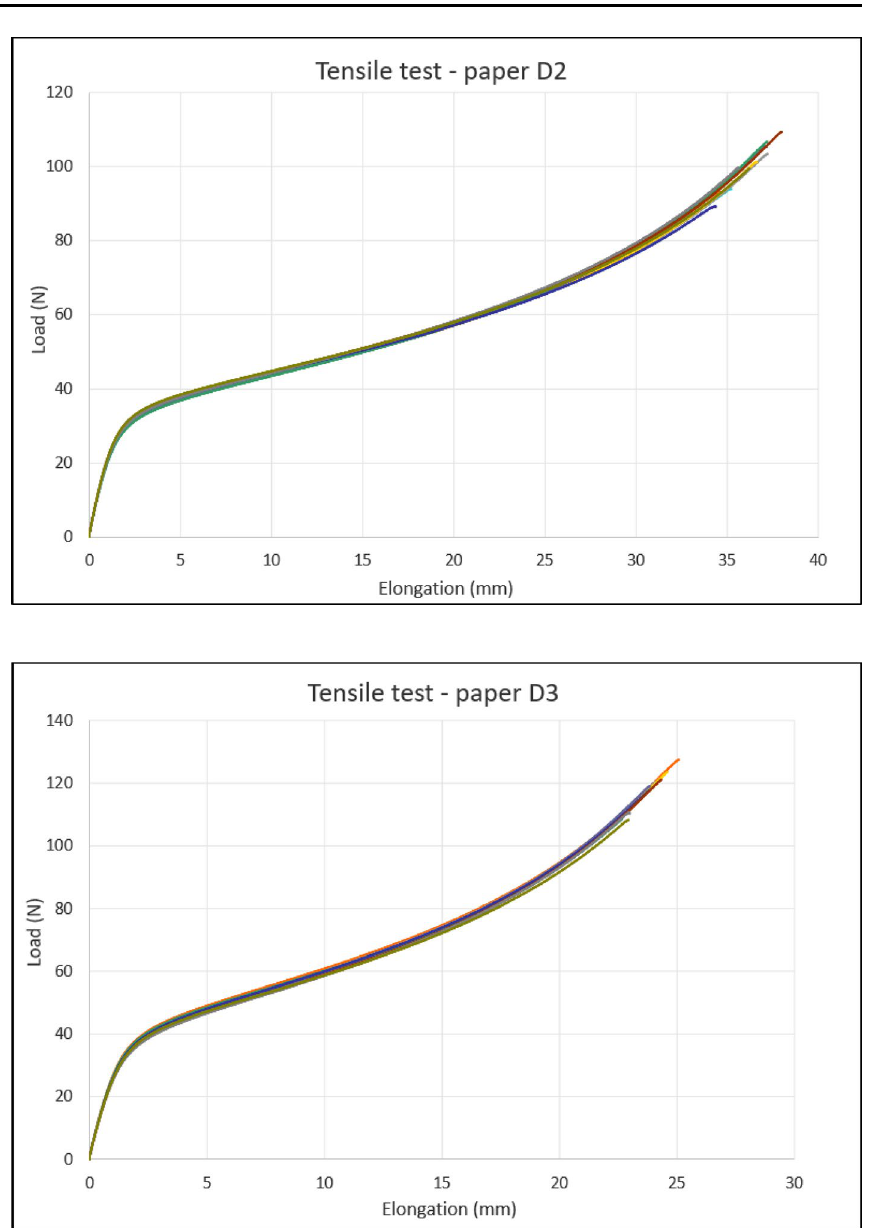
Fig. 32 Force elongation curves of individual specimen of paper D2